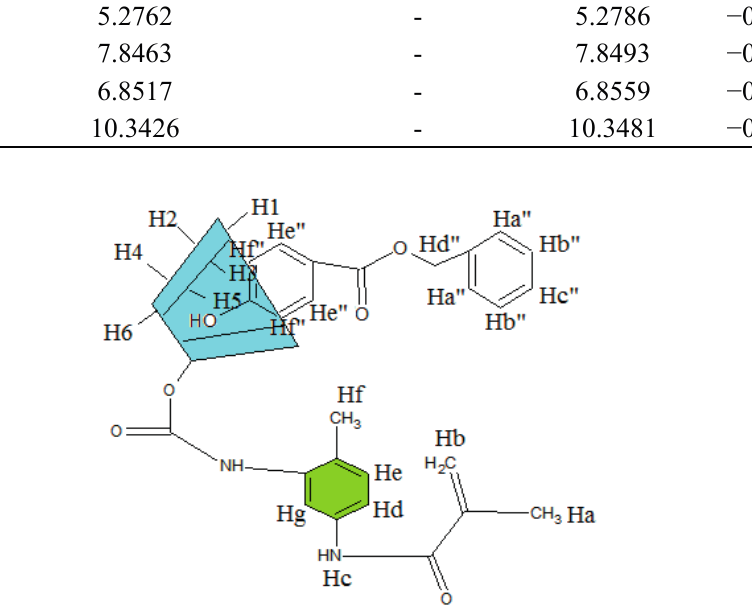
Figure 10. Proposed structure of possible inclusion complex of methacrylic acid functionalized β -cyclodextrin with benzylparaben (MAA- β -CD-BzP)